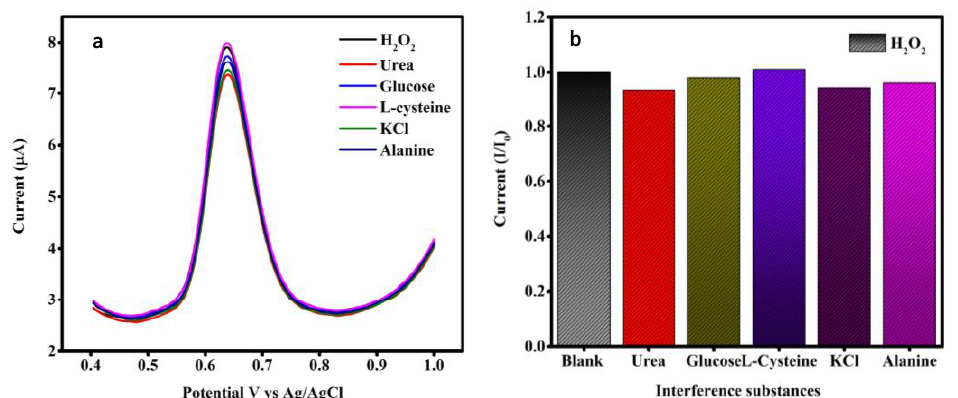
Figure 8. The interference of SGP2 modified GCE for H 2 O 2 (2 mM) was evaluated in the presence of different interference substances shown in both DPV ( a ) and bar graph ( b ).